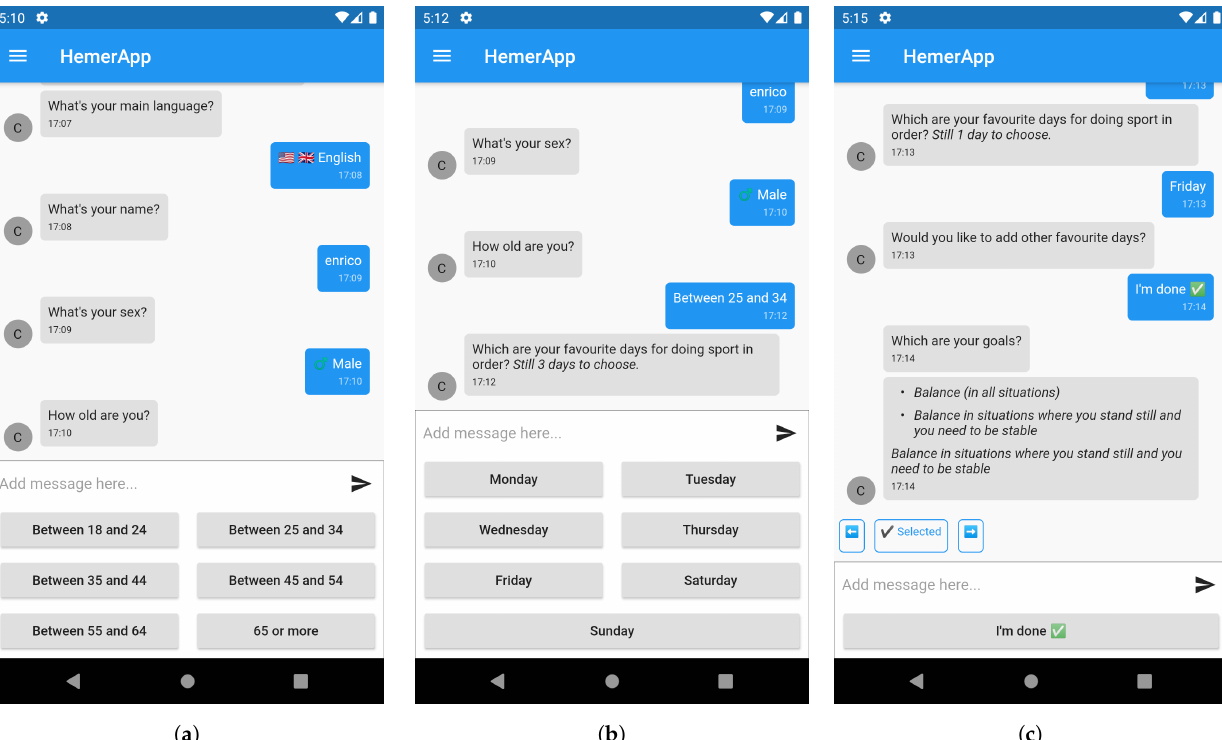
Figure 8. Front-end login interaction diagram via Telegram or HemerApp, and data flow between User, ChatApp, doctor- agent, and Pryv.